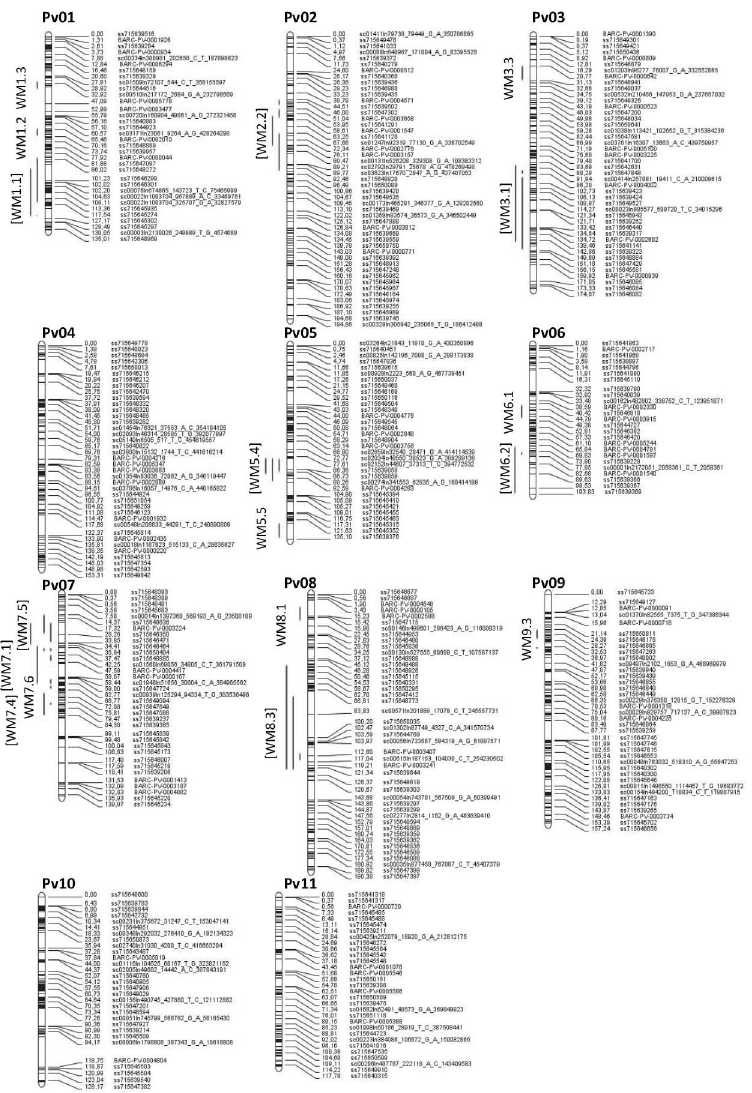
Fig 1. Representation of the individual QTL for resistance to white mold in the Stampede x Red Hawk common bean reference F 2 genetic map based on physical mapping of the 37 QTL identified from 14 RIL populations. The nine meta-QTL are in brackets. Span of the QTL is represented by the length of the red line. The physicalpositionsof the SNP markers across the 11 chromosomescan be found in the supplemental data of Song et al.